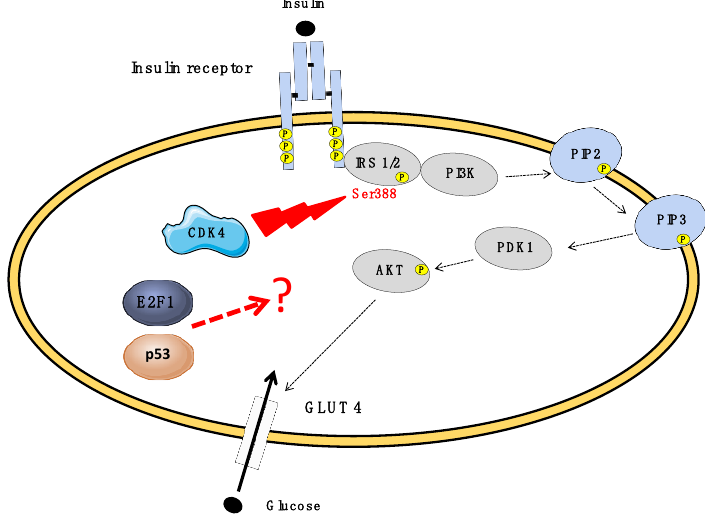
Figure 3. The INK4a / ARF locus modulates the insulin-signaling pathway in adipocyte. Insulin attaches to insulin receptor triggering intracellular autophosphorylation of their tyrosine residues, which constitutes an attachment for insulin receptor substrate (IRS) proteins. These molecules undergo phosphorylation and form a complex with PI3K. PI3K phosphorylates PIP2, which results in PIP3 formation and activation of PDK1. AKT gets phosphorylated and activated by PDK1. The latter is responsible for GLUT4 translocation to cellular membrane and glucose inflow. CDK4 was shown to activate the insulin-signaling pathway through phosphorylation of IRS2 at Ser388 upon insulin stimulation, thus maintaining insulin action in adipocytes. Although E2F1 and p53 are thought to interact with the insulin-signaling pathway to modulate AT insulin sensitivity, yet the underlying mechanisms are still unclear.